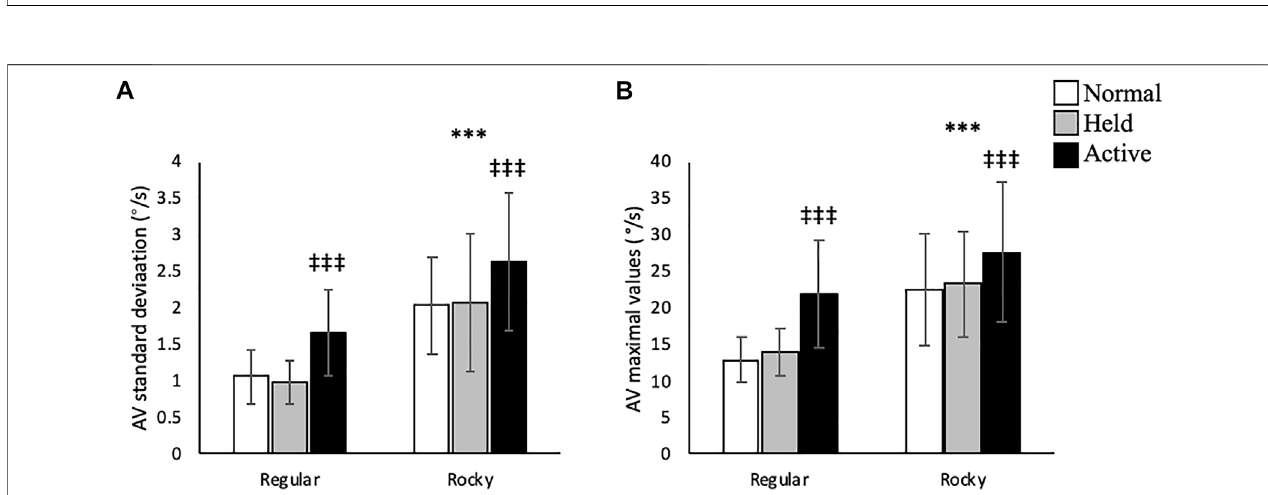
FIGURE 3 | Trunk linear velocity (A) standard deviation (m/s) and (B) maximal values (m/s) according to surface type for each arm condition in the anteroposterior direction. *** shows that rocky surface led to larger values than regular surface at p < 0.001, while ‡‡‡ shows that active arm swing led to larger values than normal and held at p < 0.001.